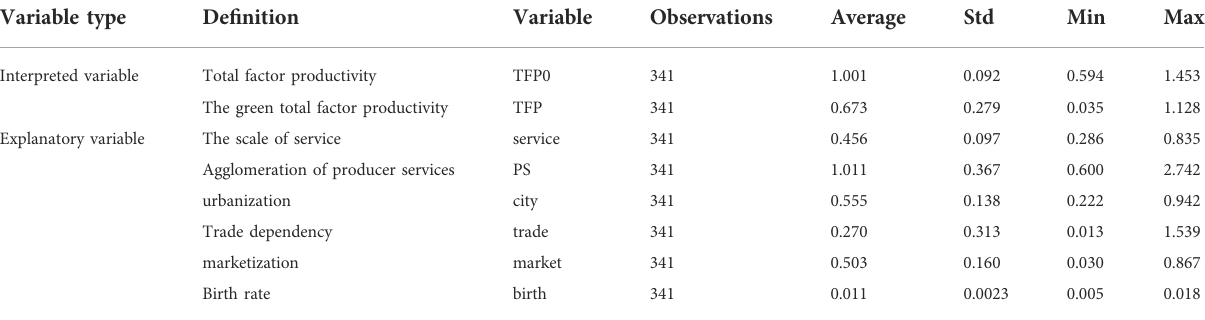
TABLE 1 Descriptive statistics of